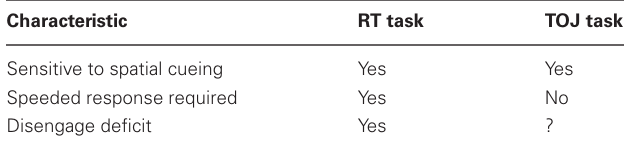
Table 1 | Summary comparison of the characteristics of the two experimental